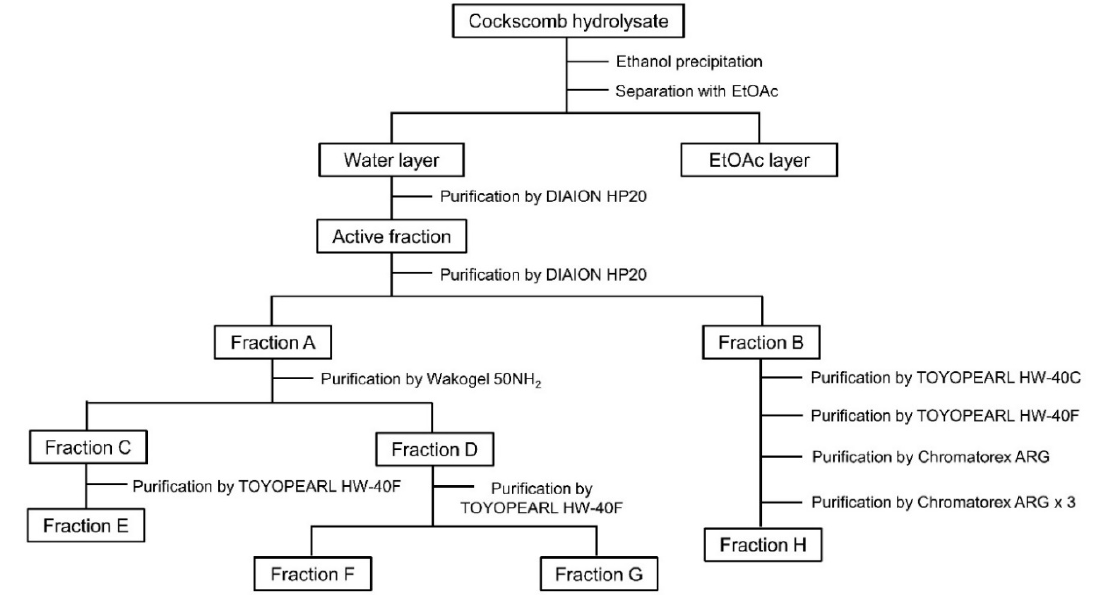
Figure 1. Purification scheme for neurite outgrowth-promoting compounds contained in cockscomb hydrolysate.